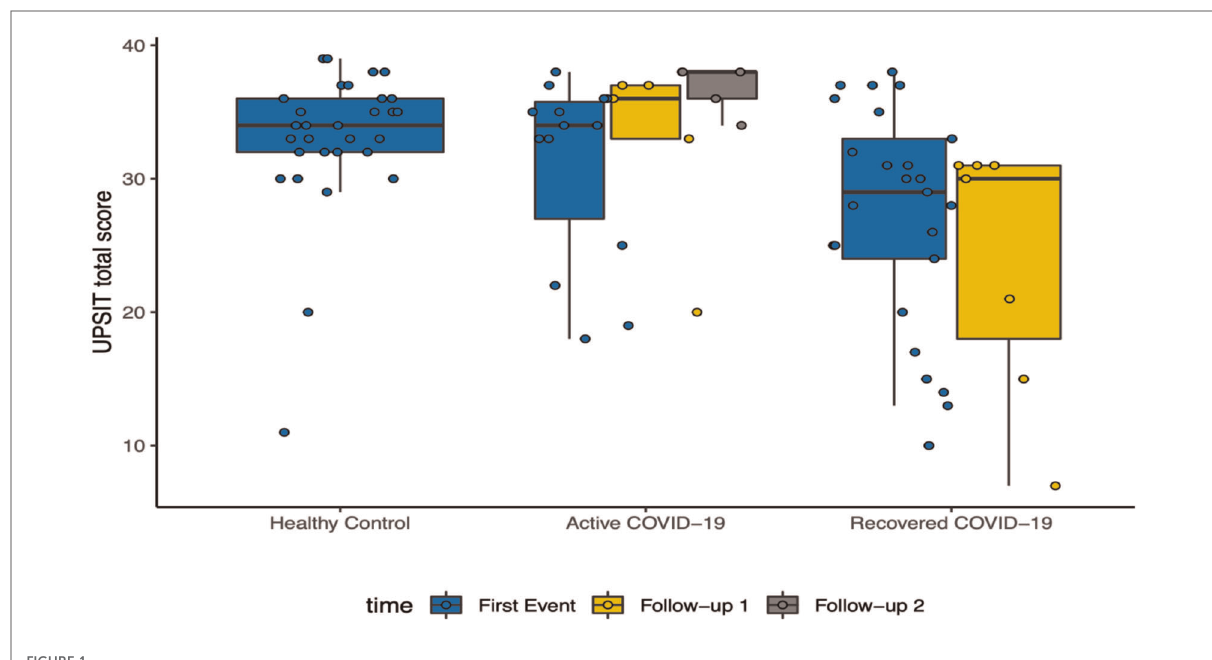
FIGURE 1 UPSIT scores over the course of follow ups.